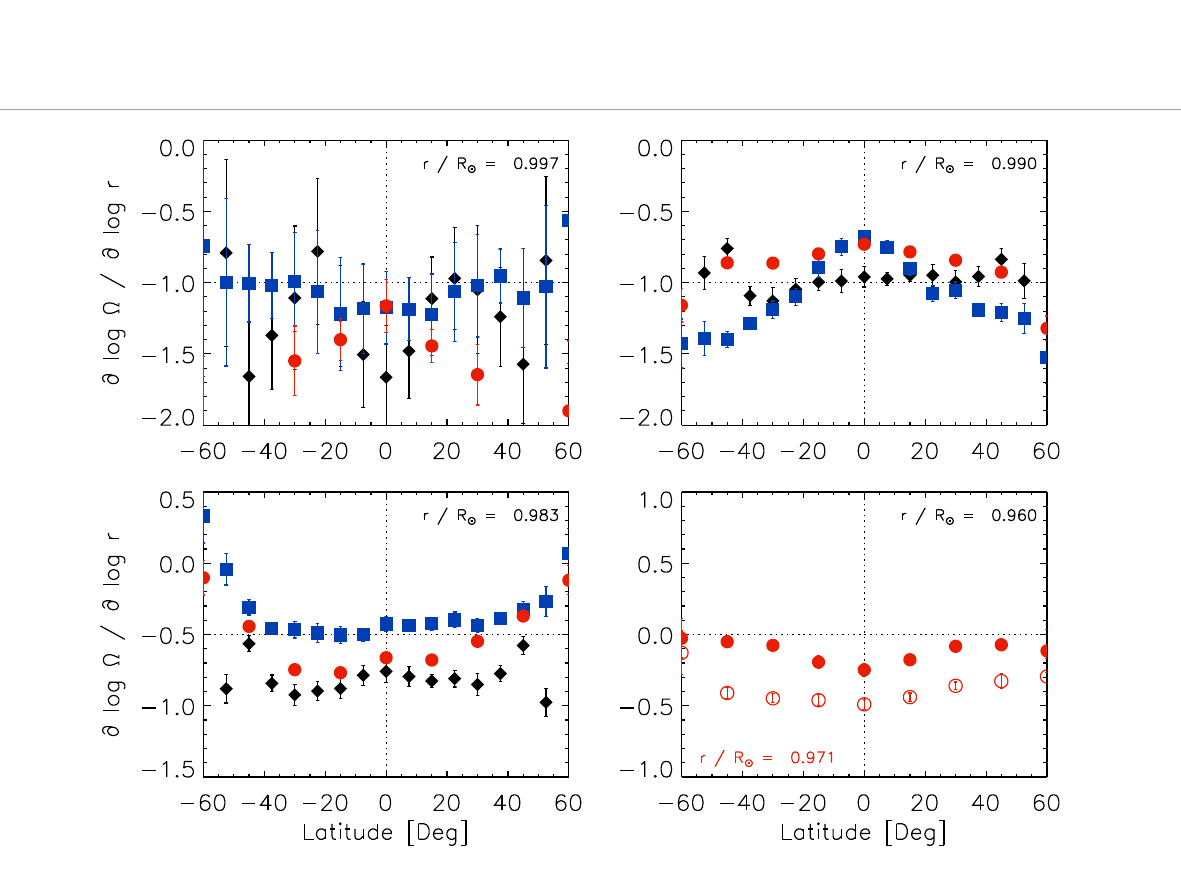
FIGURE 3 The radial gradient of the solar rotation rate as a function of latitude at four depths (top-left: .997 R ⊙ , top-right: .990 R ⊙ , bottom-left: .983 R ⊙ , bottom-right: .960 R ⊙ ) using 15°-tile RDA (black diamonds: GONG, blue squares: HMI) and 30°-tile RDA (red circles: HMI) averaged over Solar Cycle 24. The open symbols indicate values at .971 R ⊙